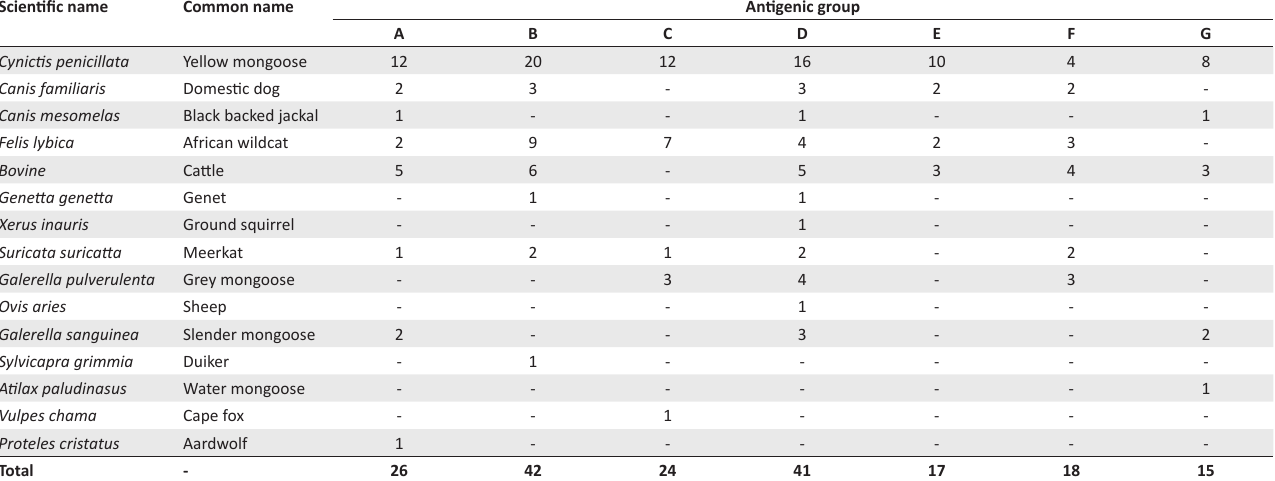
TABLE 6: The distribution of mongoose rabies virus variant antigenic reactivity patterns by host species.